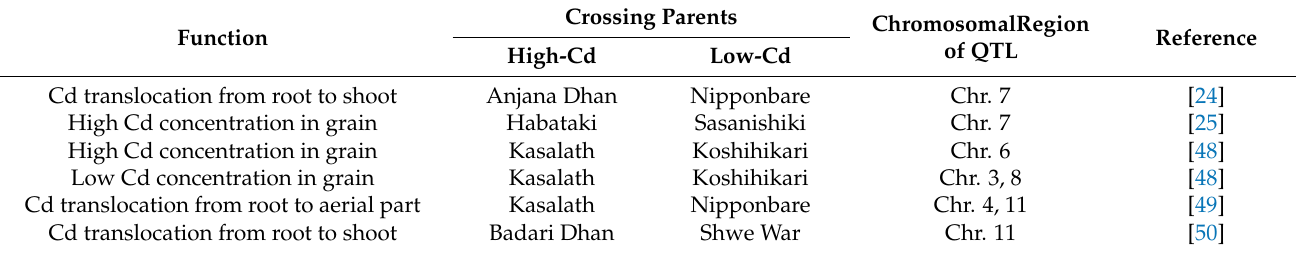
Table 3. QTL region and the function reported